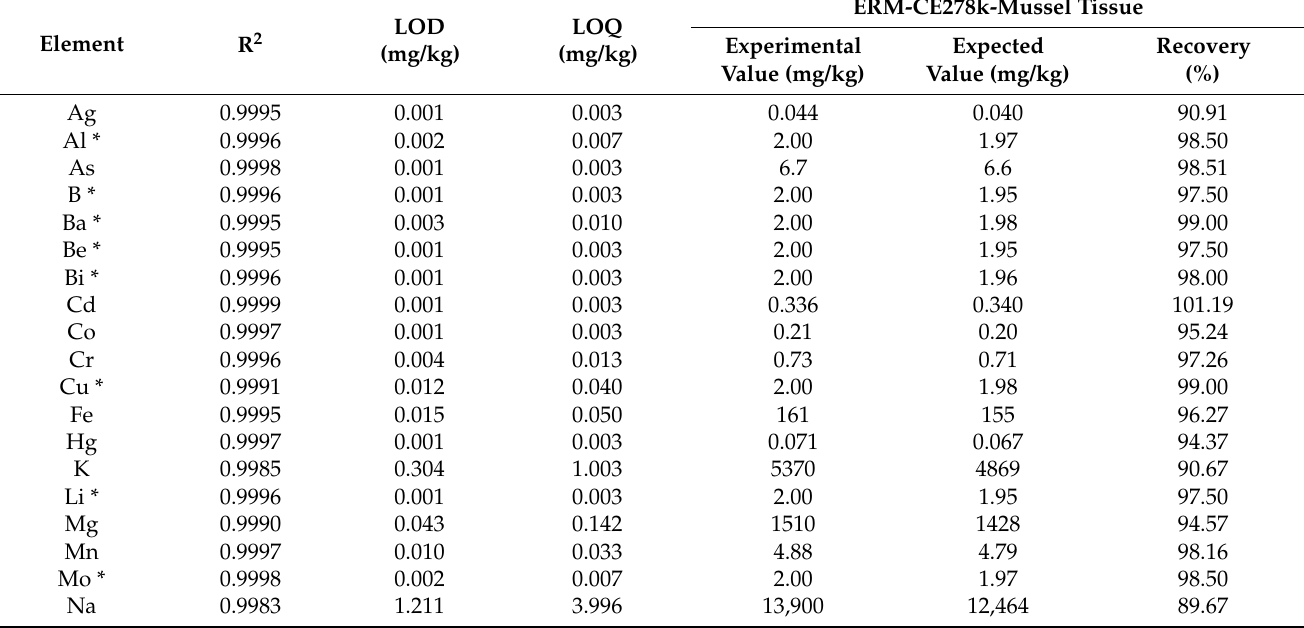
Table 2. Analytical parameters for method